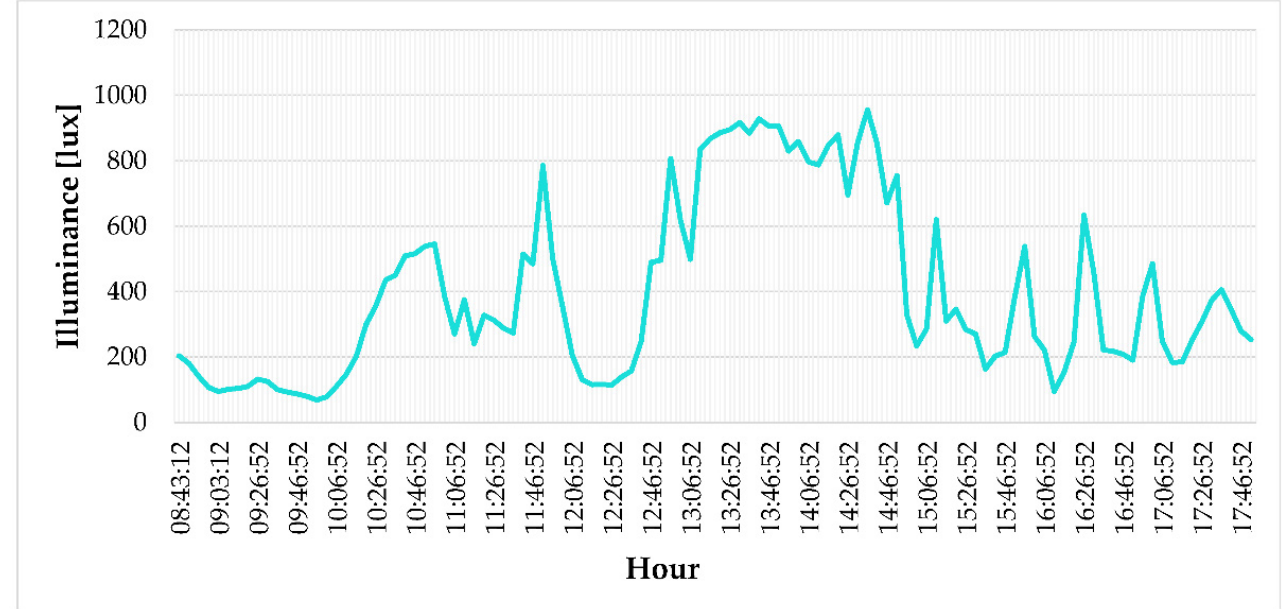
Figure 12. Light intensity measurement in the experimental chamber, at a height of 0.785 m, on 1 April 2014.